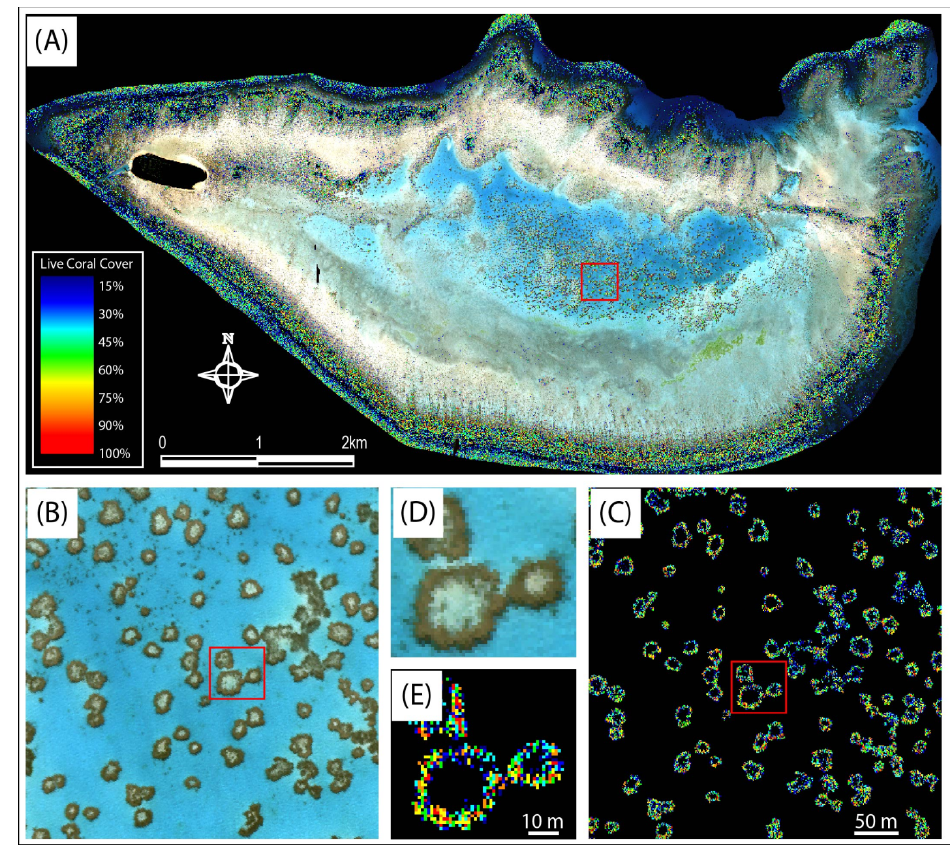
Figure 10. ( A ) Overlay of live coral cover index applied to CASI-2 image of Heron Reef; ( B ) CASI-2 subset from deep lagoon; ( C ) live coral cover index application from deep lagoon; ( D ) CASI-2 subset from patch reef in lagoon; and ( E ) live coral cover index application from patch reef in lagoon. NB: The same live coral cover scale shown in ( A ) is used in ( C ) and ( E